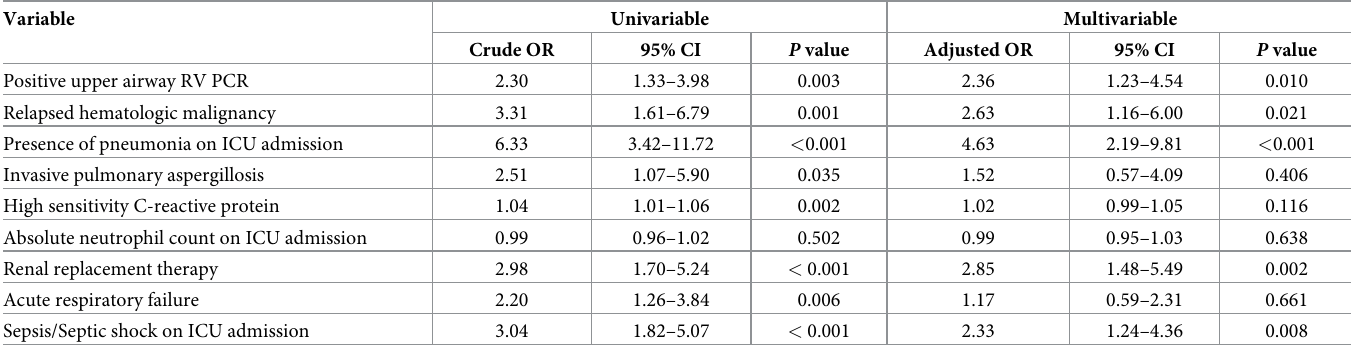
Table 3. Clinical factors affecting hospital